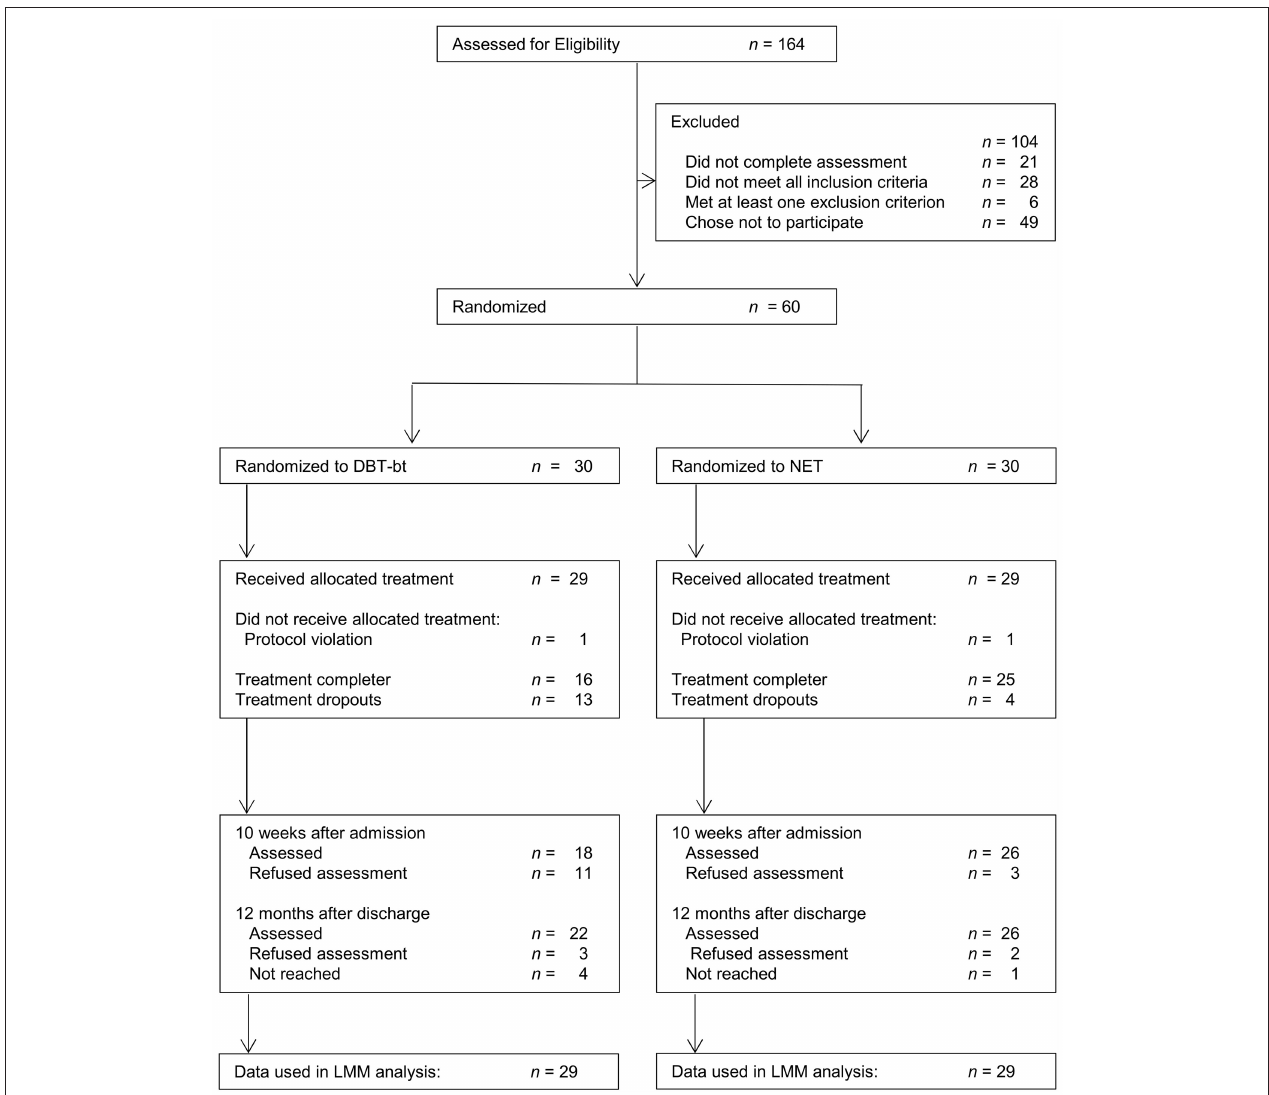
FIGURE 1 | Patient flow. DBT-bt, Dialectical Behavior Therapy (DBT) based treatment; NET, Narrative Exposure Therapy; LMM, Linear Mixed